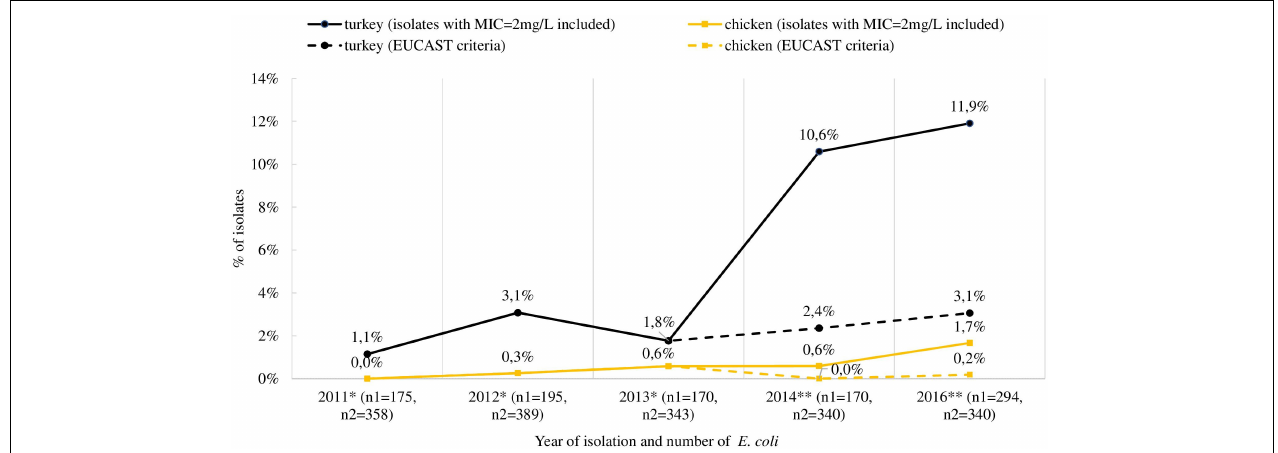
FIGURE 3 | Occurrence of mcr-1 -positive E. coli in Poland isolated from turkey and chicken fecal samples. ∗ isolates collected in multiannual governmental programs (according to of the Council of Ministers Decisions), ∗∗ isolates deriving from official monitoring according to Decision 2013/652/EC and thus not encompassing samples from turkeys and broilers in 2015; n1 and n2 indicate the total number of isolates tested for MIC determination from turkeys and chickens (both broiler and laying hens), respectively. The occurrence of mcr-1 positive strains when using exclusively EUCAST ECOFF during selection of isolates was also included (dashed